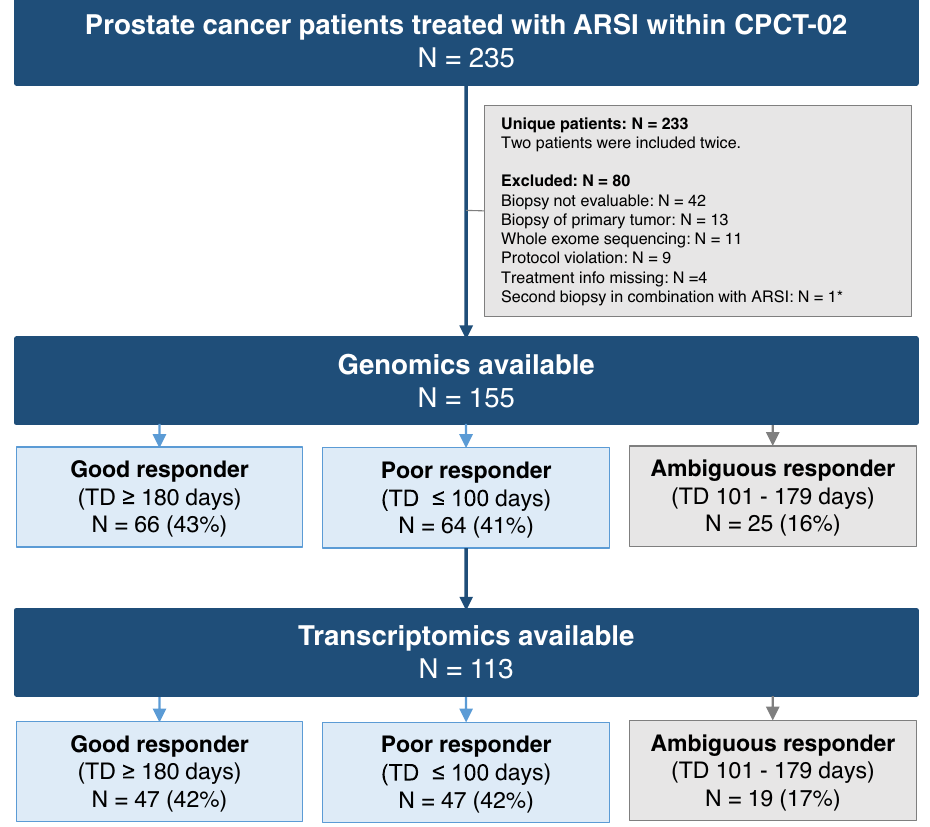
Fig. 1 | Overview of mCRPC patients, treated with ARSI post-biopsy, within CPCT-02 cohort. Of the 235 mCRPC patients, who were treated with androgen receptor signaling inhibitors (abiraterone acetate + prednisone (AAP) or enzalu- tamide; ARSI) and included in the CPCT-02 study, genomics and transcriptomics were available for 155 and 113 patients, respectively. Patients were strati fi ed